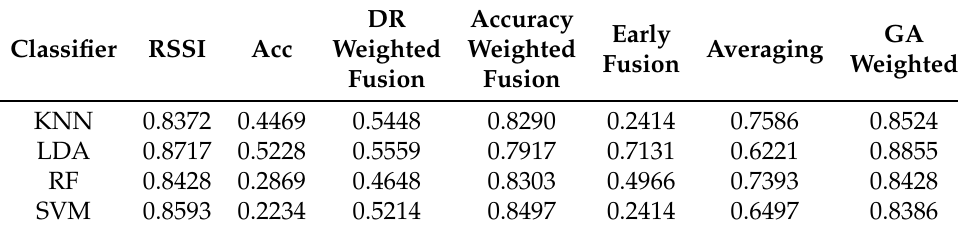
Table 8. Accuracy values for the bedroom gateway.